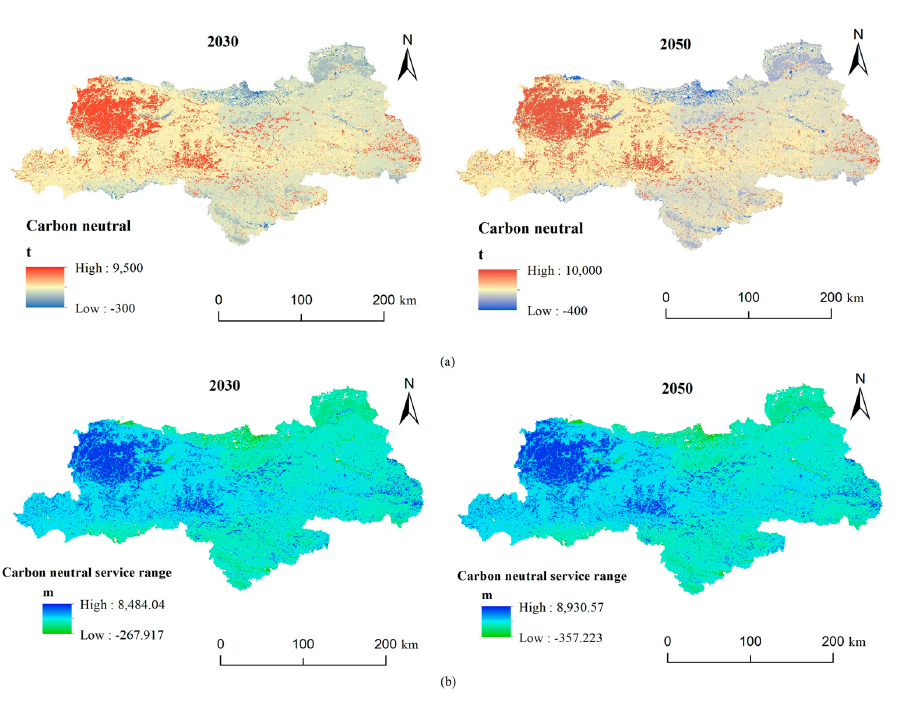
Figure 7. Simulation of carbon neutrality spatial distribution ( a ) and its spatial service scope in 2030 and 2050 for the Qinling Mountains ( b